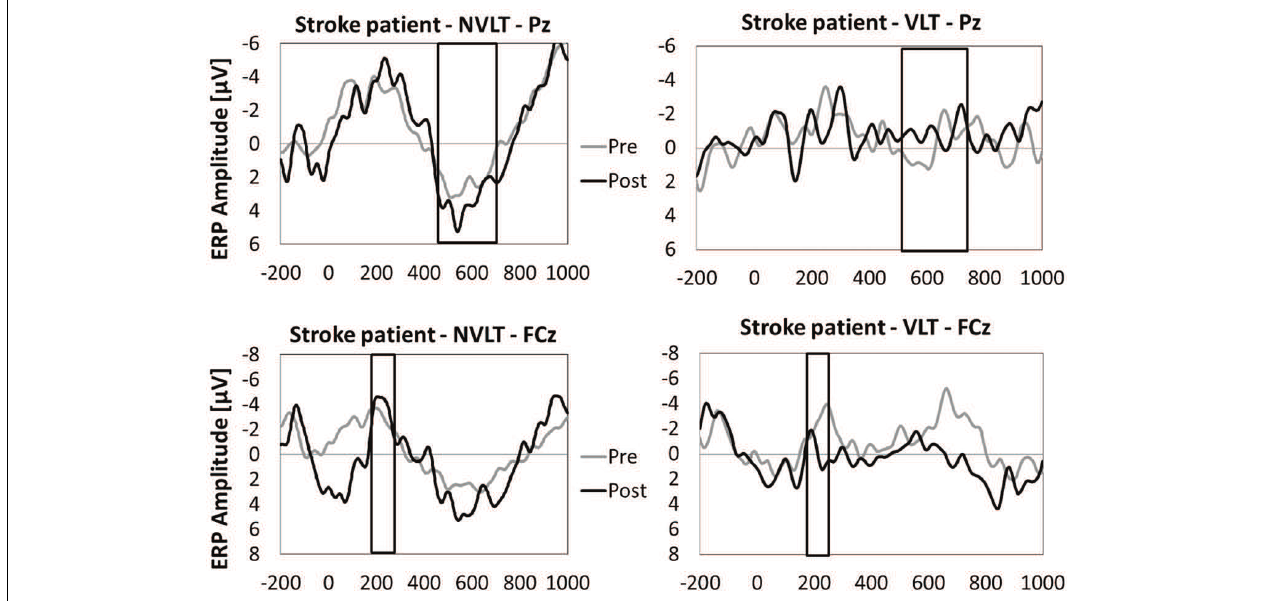
FIGURE 5 | Grand average event-related potentials (FCz and Pz) during the encoding phase of the non-verbal learning task (NVLT) and the verbal learning task (VLT), for the pre- and post-measurement of the healthy elderly group. The analyzed latency windows are marked with rectangles.